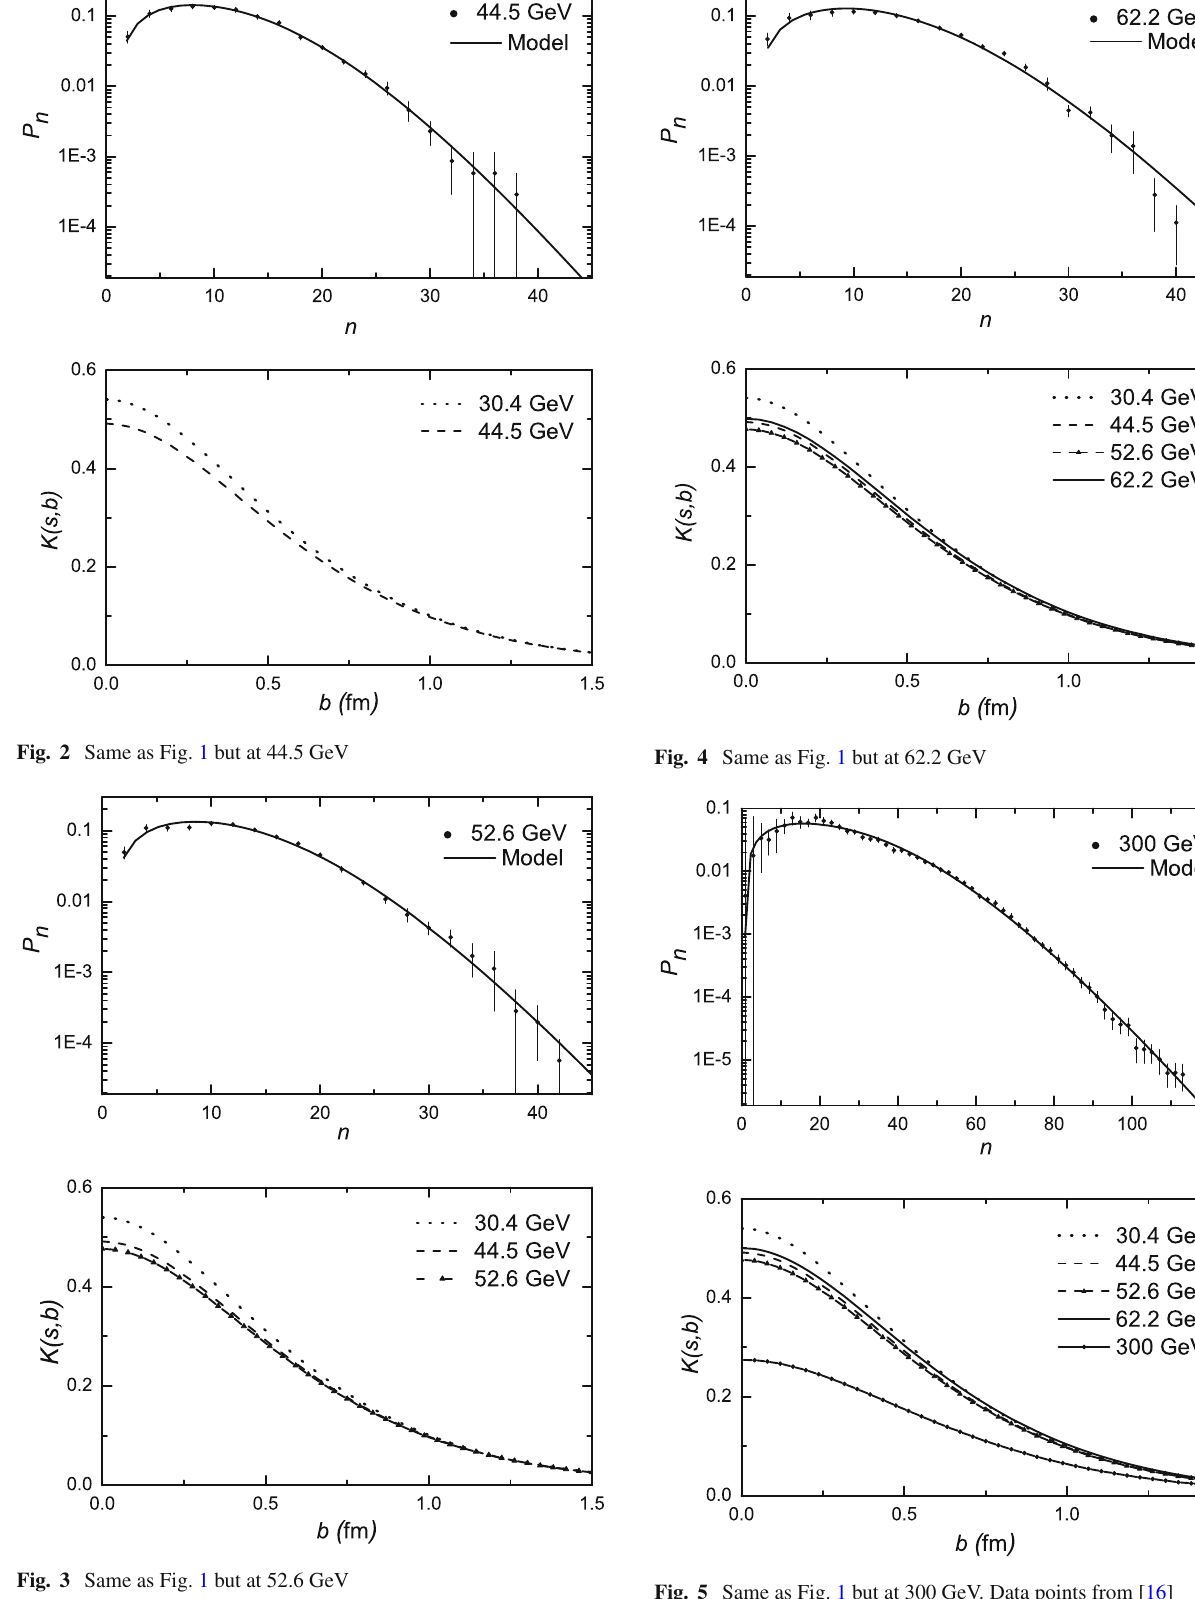
Fig. 5 Same as Fig. 1 but at 300 GeV. Data points from